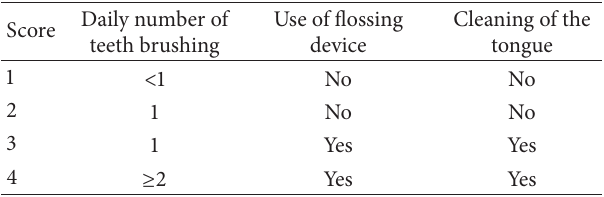
Table 2: Clinical protocol used for gingival pemphigus vulgaris